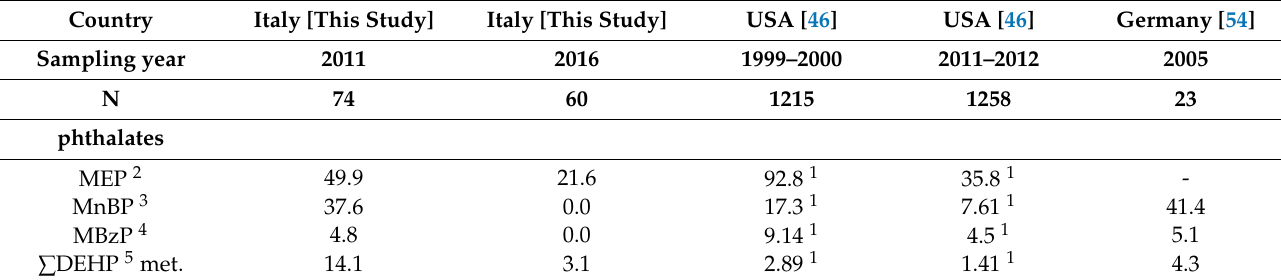
Table 8. Comparison among biomonitoring median data in different geographical areas—men ( µ g/g creatinine). Country Italy [This Study] Italy [This